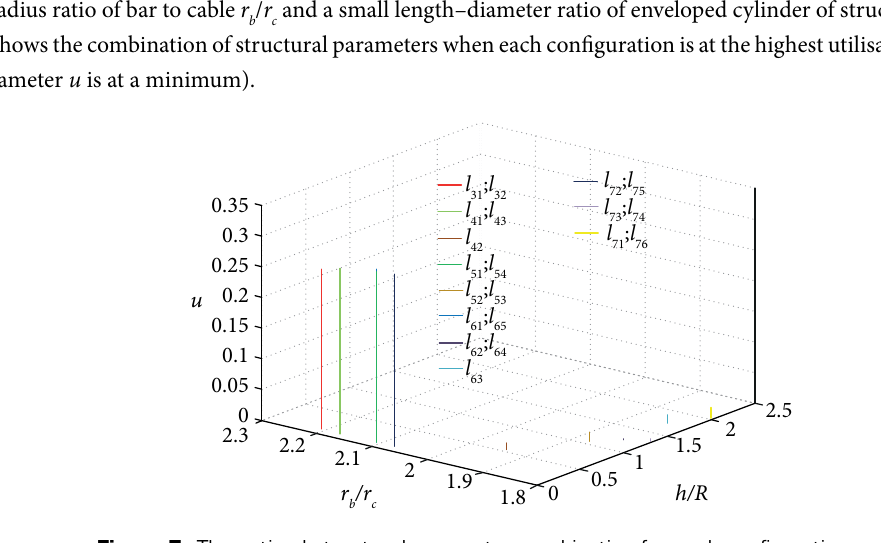
Figure 7. The optimal structural parameter combination for each configuration.